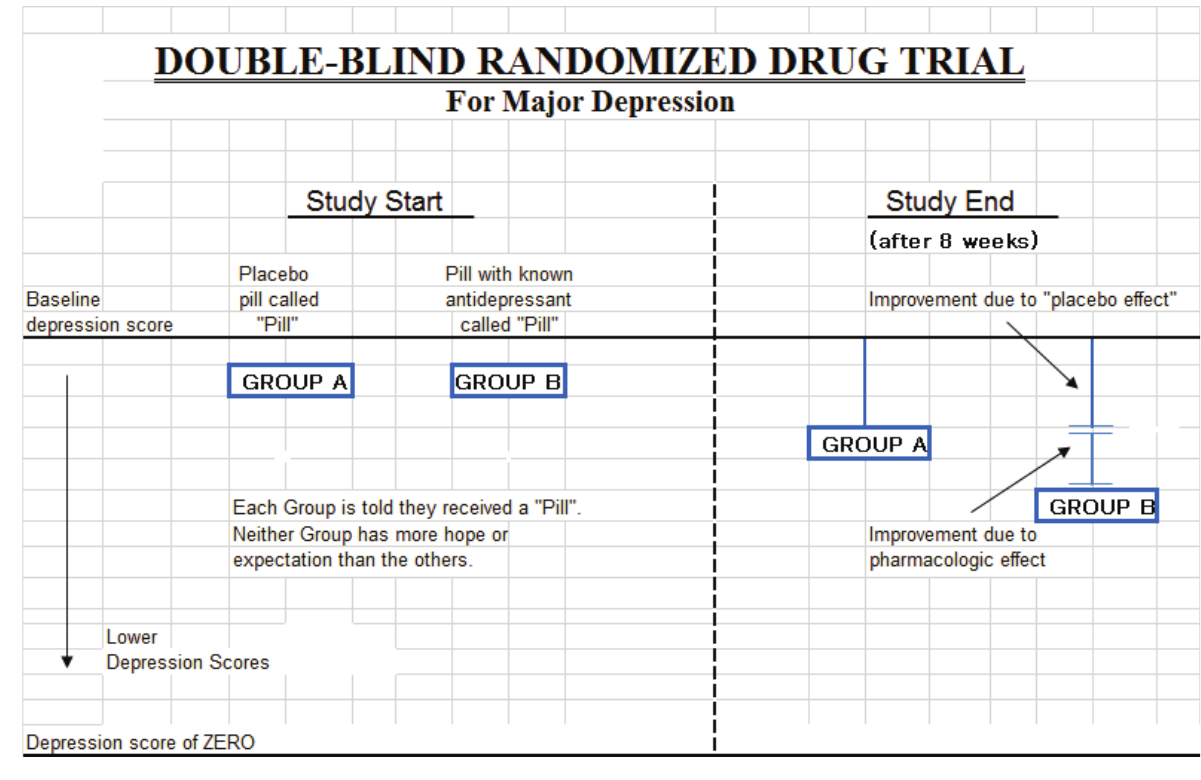
Figure 1. Double-blind randomized drug trial.